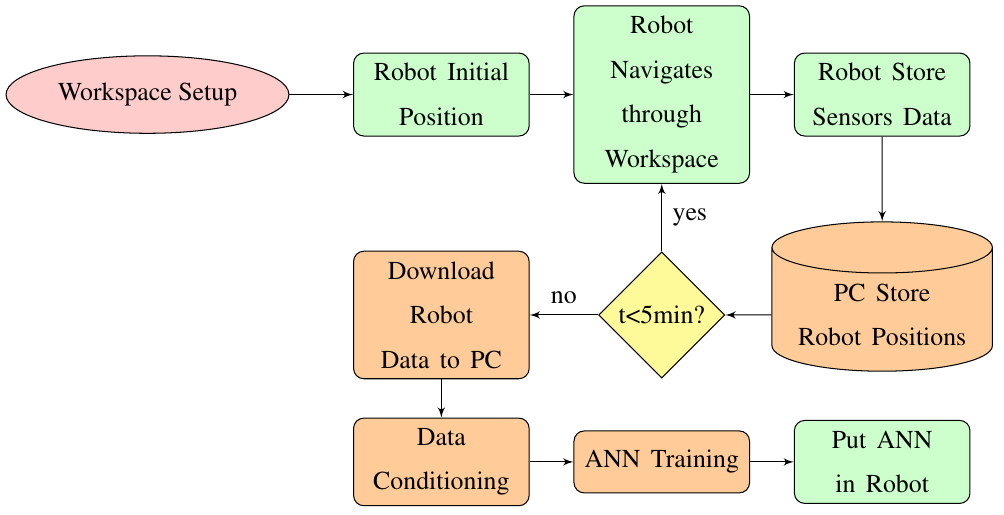
Figure 14. Flow diagram of the developed calibration procedure